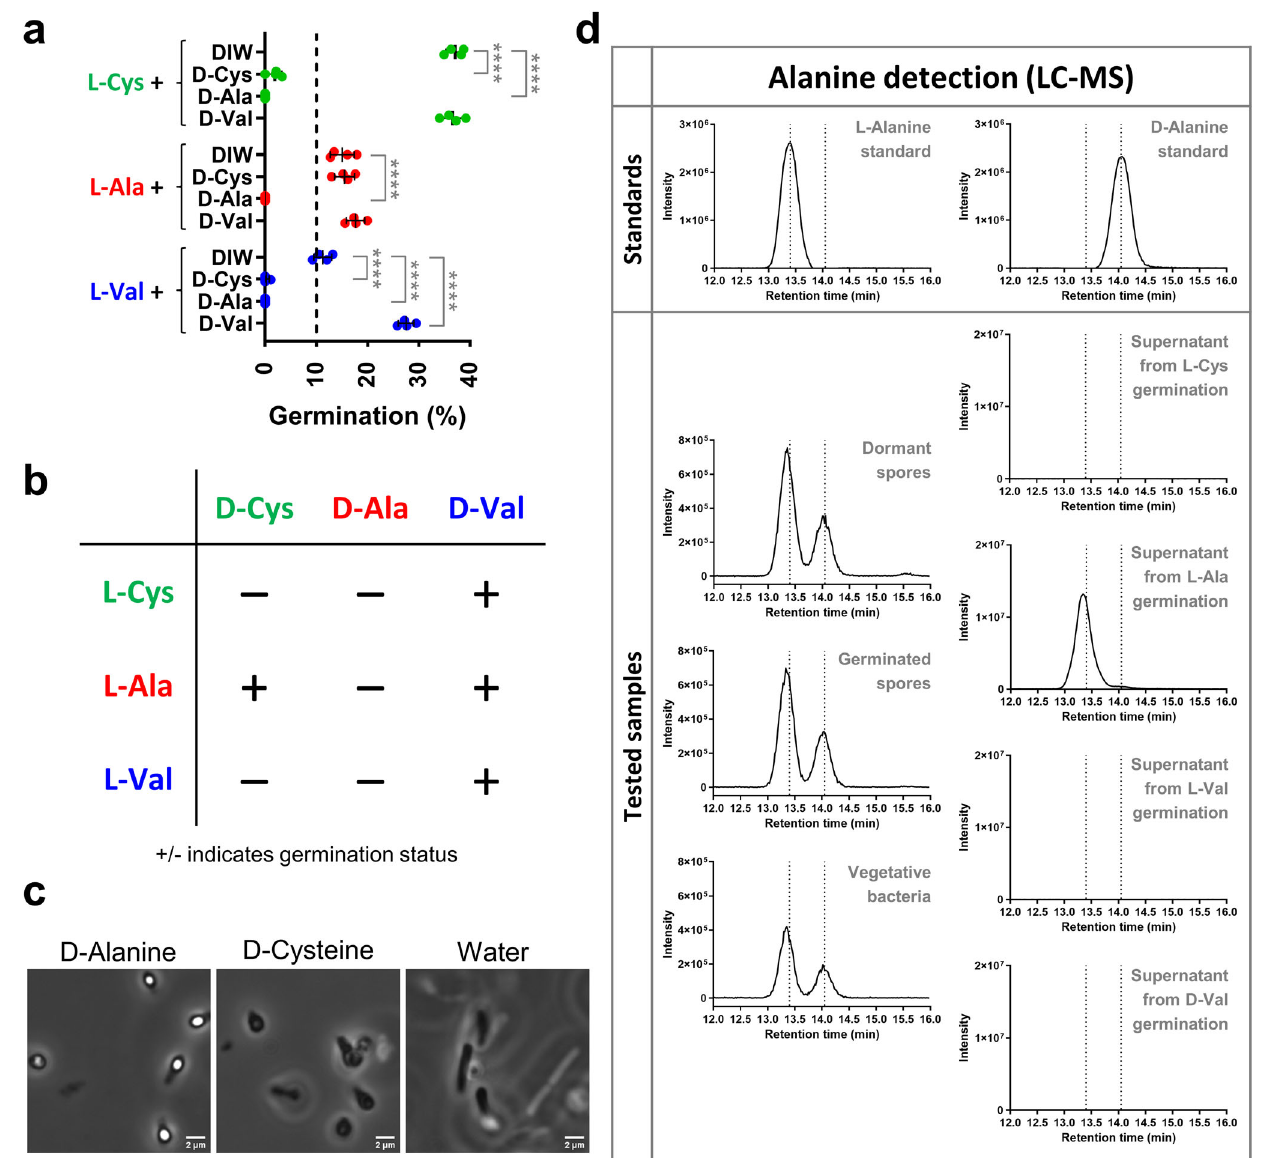
Fig. 4 Inhibition of C. novyi -NT spore germination by D-alanine. a Scatter dot plot of percent germination (as de fi ned in Supplementary Table 4) by L-amino acid germinants (91.5 mM) in the presence of candidate D-amino acid inhibitors (91.5 mM). Green, red and blue circles refer to L-cysteine, L- alanine, and L-valine, respectively. All data depict mean ± SD, n = 4 biologically independent samples. Signi fi cance at **** p ≤ 0.0001 (Unpaired t-test). b Summary table of results from ( a ). c Phase contrast images of spores inoculated overnight in RCM-FBS oxyrase media containing D-alanine (93.5 mM), D-cysteine (93.5 mM) and Water. Images are best representative from two independent experiments. Magni fi cation 1600×, Scale bar 2 µ m. d LC-MS EIC spectra of derivatized alanine ion (351 m/z) for Standards of L-alanine, D-alanine and Samples of peptidoglycan extracts from dormant spores, germinated spores, vegetative bacteria, and supernatants from spores germinated in L-cysteine, L-alanine, L-valine or D-valine. Dotted lines represent standard peaks for L-alanine and D-alanine at retention times of 13.4 and 14.05 min, respectively. Data shown is the best representative of water blank subtracted spectra from two independent